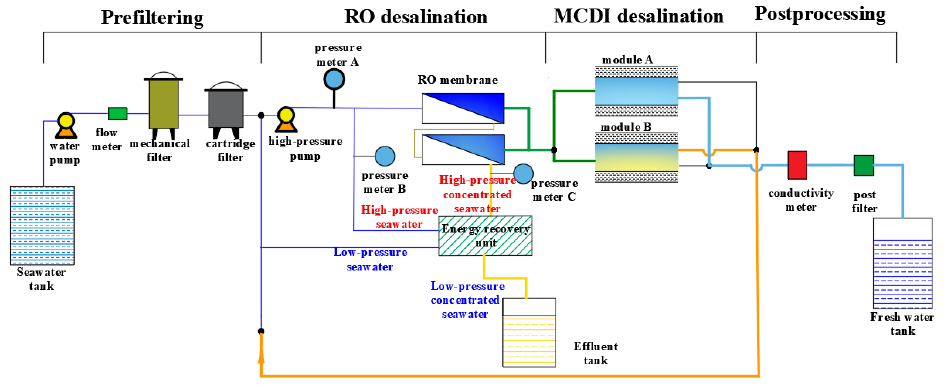
Figure 1. Schematic diagram of waterway system with coupling of one-stage two-section reverse osmosis (RO) and membrane capacitive deionization (MCDI).